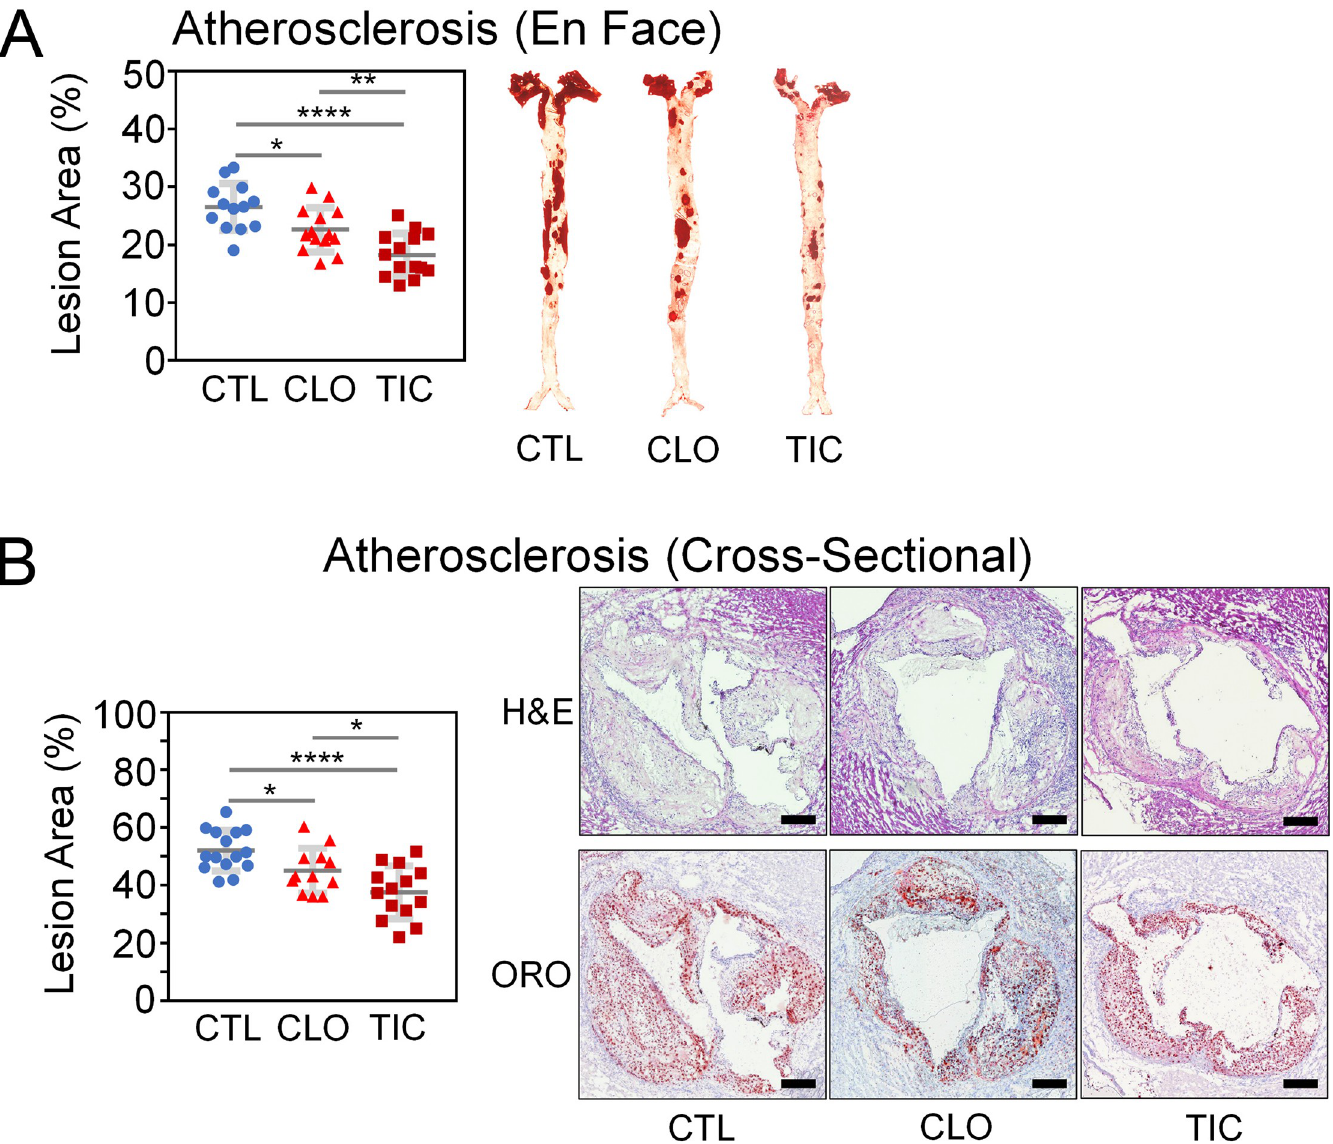
Fig 2. Ticagrelor exhibits superior protection against atherosclerosis compared to clopidogrel in the Ldlr -/- Apobec1 -/- hypercholesterolemic mice on a high-fat diet (HFD). Abbreviations: CTL, control; CLO, clopidogrel; TIC, ticagrelor; H&E, hematoxylin & eosin; ORO, oil red o; Size bars, 300 μ m; N = 12–15 per group; Error bars, means ± SD, statistical analyses performed using ANOVA with Fisher’s multiple comparison; NS, not statistically significant; � , P < 0.05; �� , P < 0.01; ���� , P < 0.001 (See also S2 Fig) . Both en face (A) and cross-sectional (B) analyses show that TIC-treated animals were better protected against atherosclerosis than are CLO- or CTL-treated animals. CLO-treated animals exhibited less atherosclerosis than CTL-treated animals